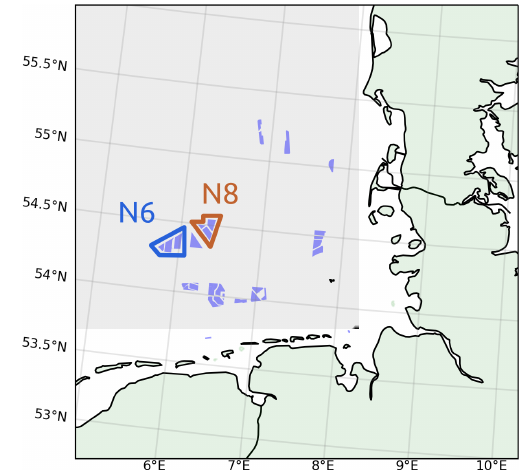
Figure 2. German Bight, selected area for calculating mean wind direction changes. The wind farms currently commissioned and whose consent was authorized in the German Bight are marked in blue (data from Bundesamt für Seeschifffahrt und Hydrographie, 2020). The wind farms of the N6 cluster are framed in blue, whereas the ones of the N8 cluster are framed in orange. The coastline and border data originate from the Natural Earth dataset (Natural Earth,